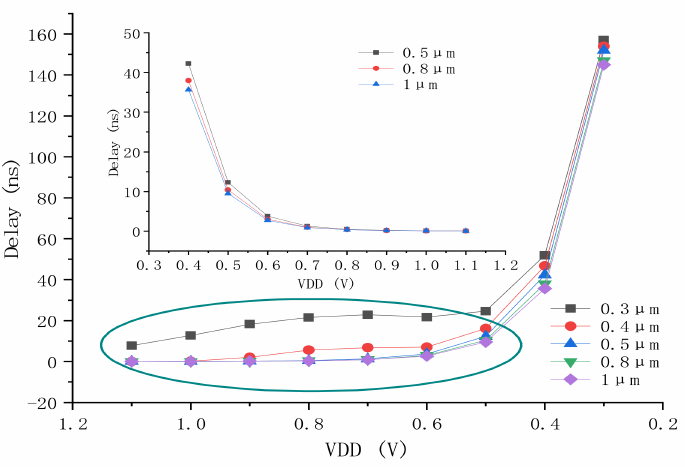
Figure 6. The delay of timing detection with various transistor sizing and supply voltages. Table 3. The power, delay and PDP of the proposed ETFF with transistor